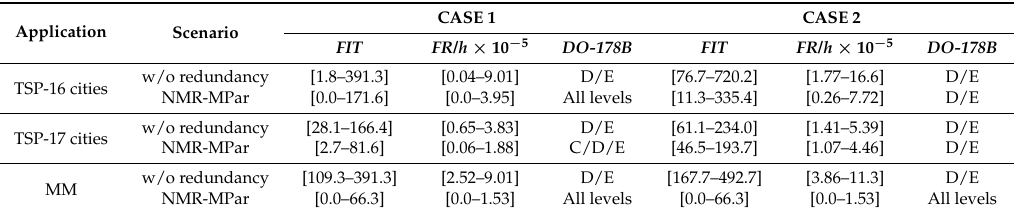
Table 11. Failure-rate of the evaluated